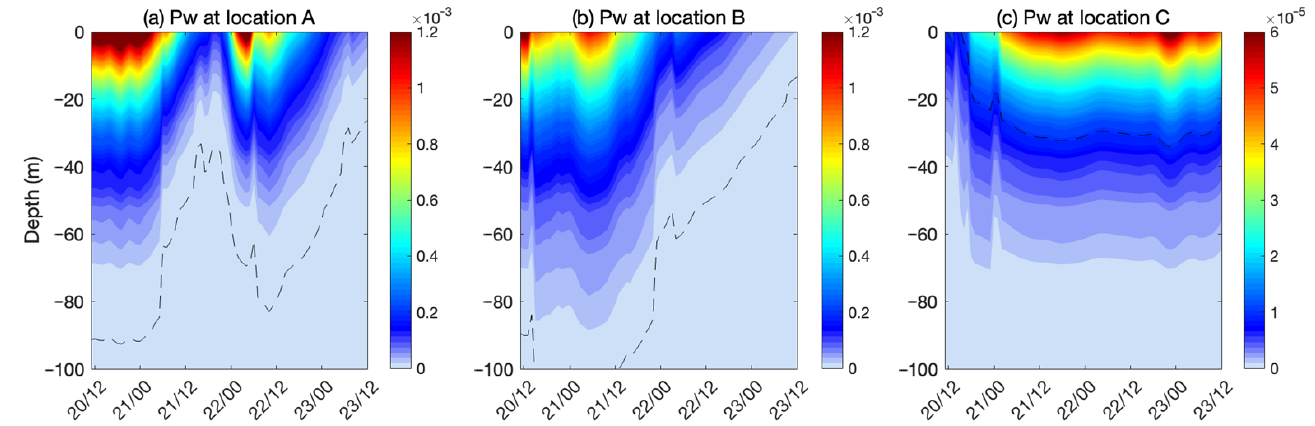
Figure 6. The turbulence production induced by wave orbital motion P W (m 2 /s 3 ) at locations A, B, and C in experiment E2. The black dashed lines represent the isoline of 1 × 10 − 5 m 2 /s 3 .